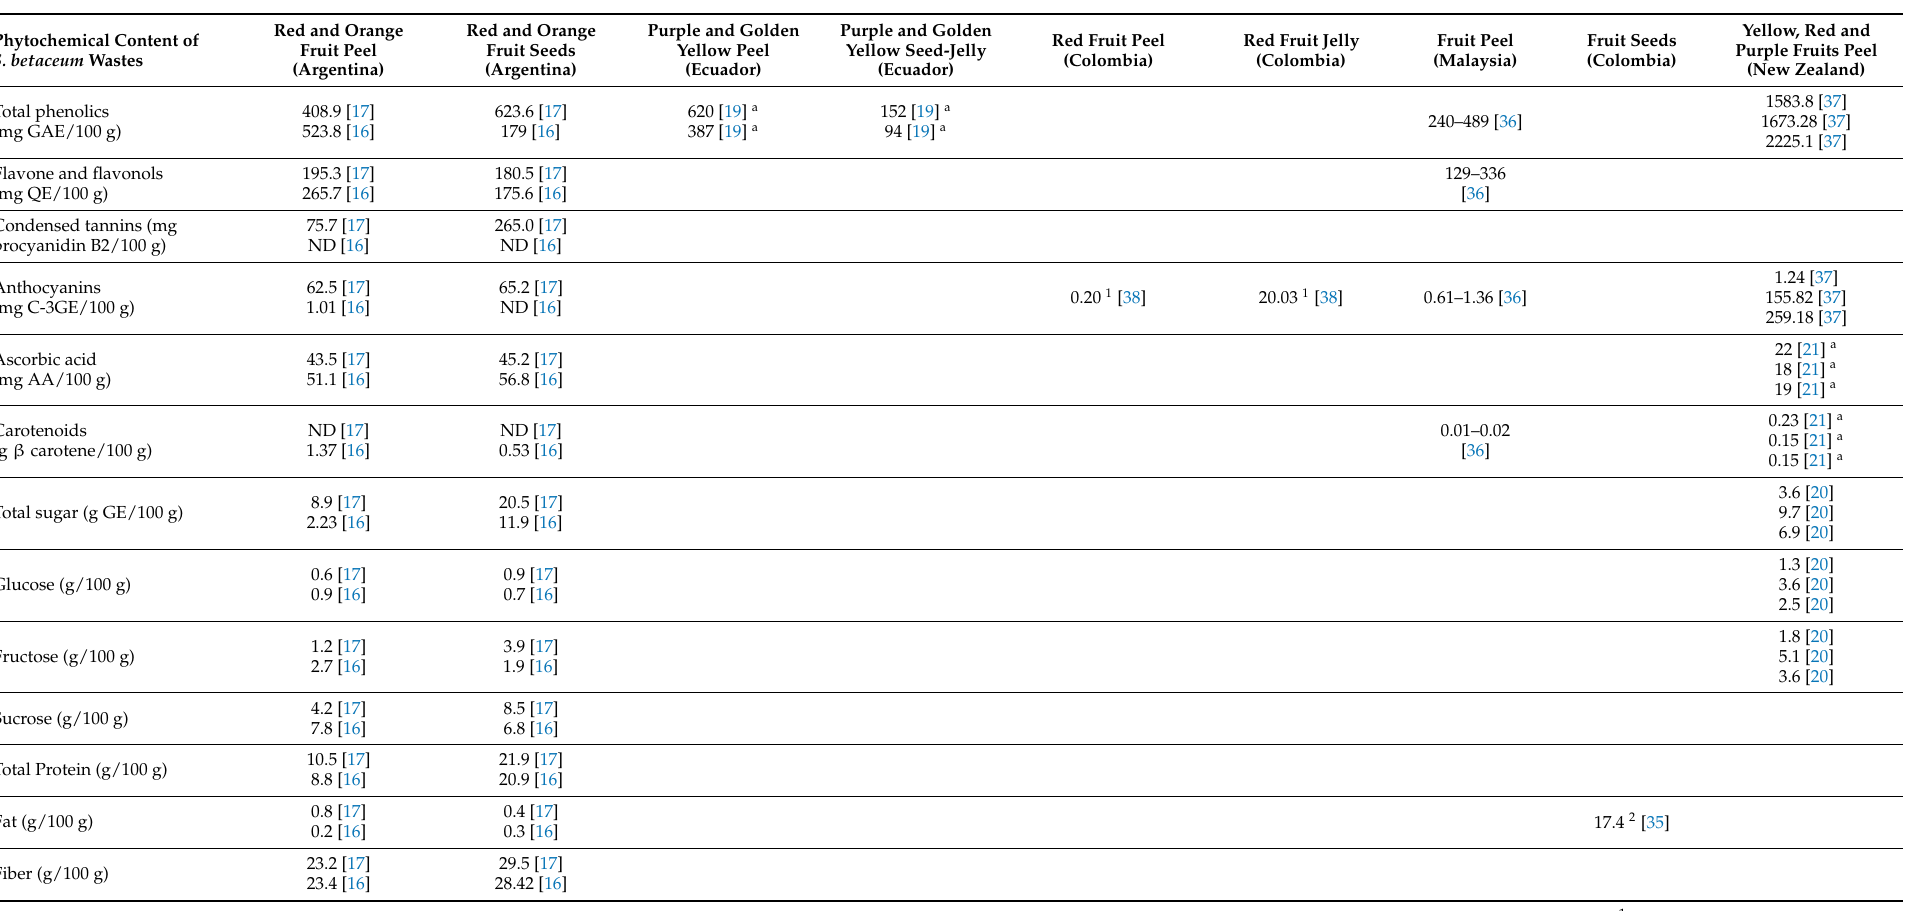
Table 2. Phytochemical composition of S. betaceum